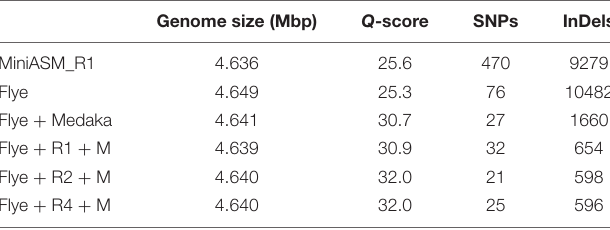
TABLE 2 | Assembly quality for E. coli strain K12 substr. BOP27 at different steps in the pipeline for reads basecalled with the high accuracy algorithm with methylation calling